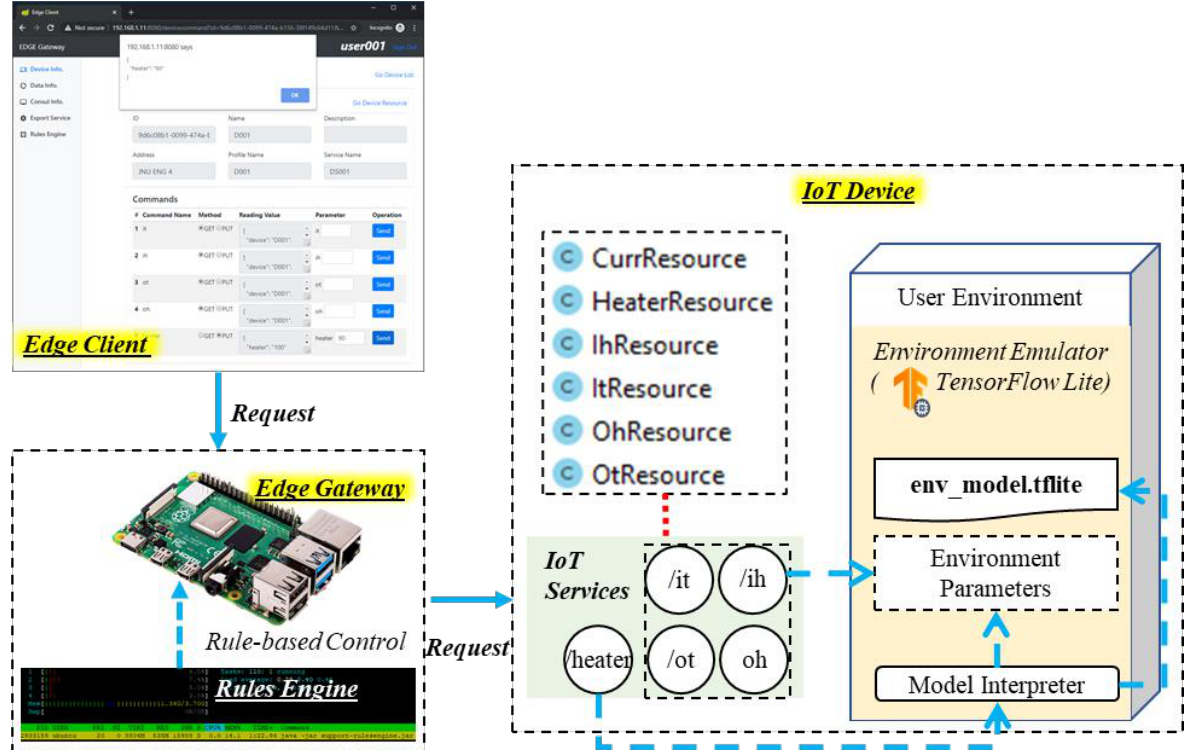
Figure 10. Implementation result of accessing IoT device based on rules engine and edge client.